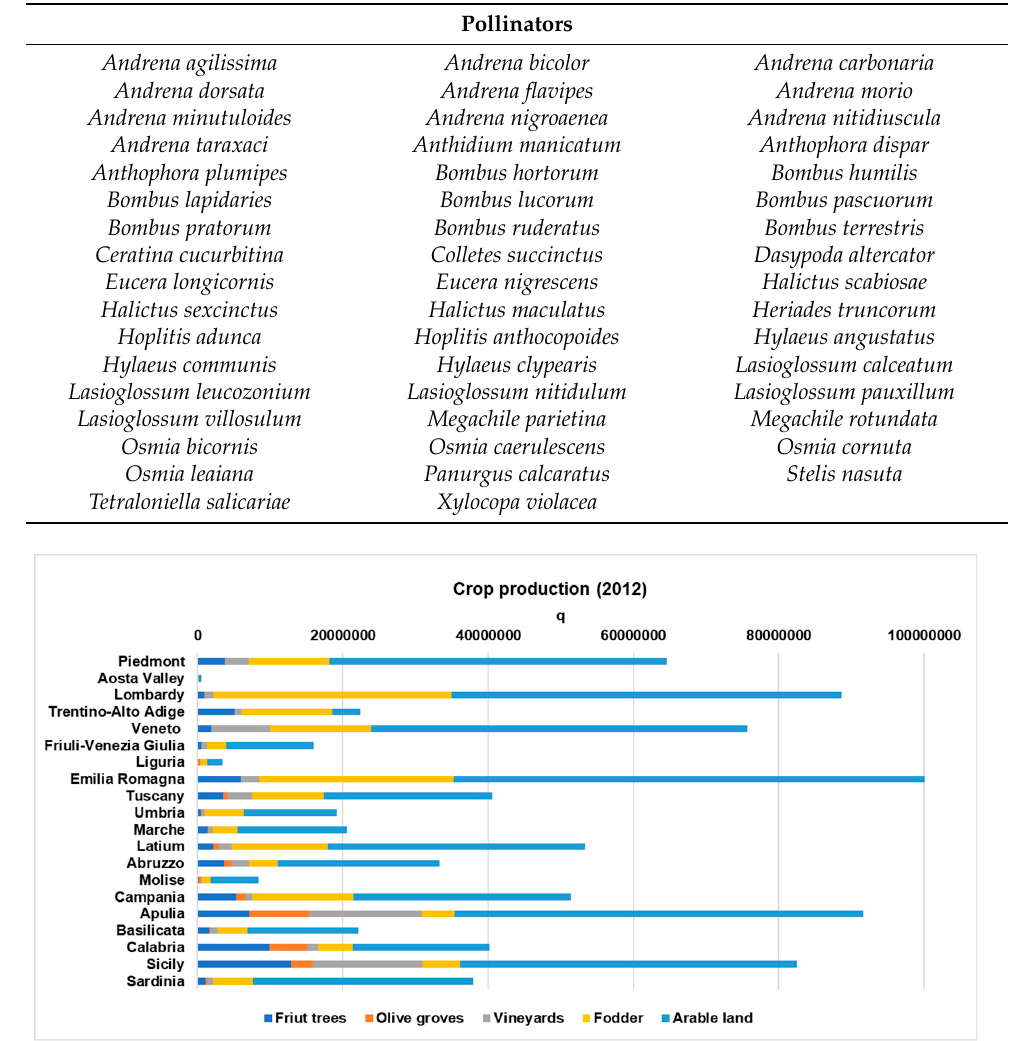
Figure 4. Estimation of crop production (quintals) for five agricultural classes in 2012 at the regional